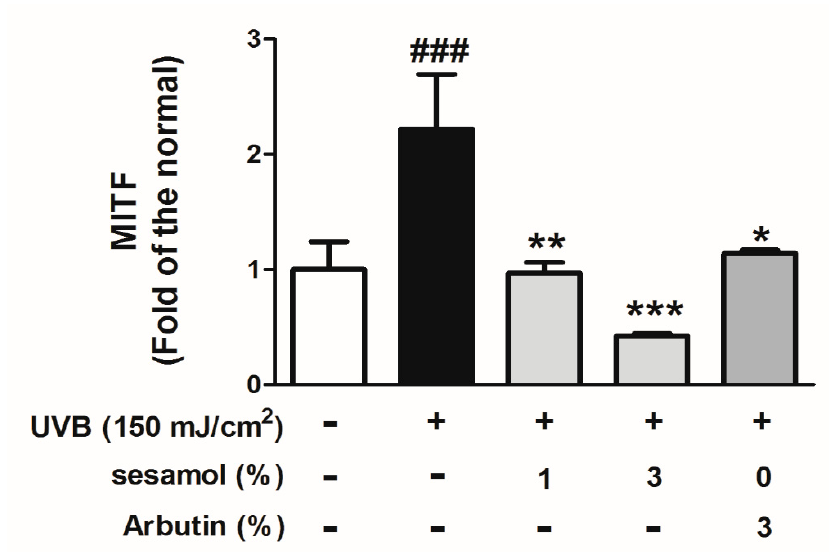
Figure 12. Light micrographs of histological sections stained with microphthalmia-associated transcription factor (MITF) in UVB-irradiated C57BL/6 mice that received topical application of sesamol once a day to the ear skin. (Significant difference versus control: ###, p < 0.001. Significant difference versus UVB treated group: *, p < 0.05, **, p < 0.01, ***, p < 0.001.).